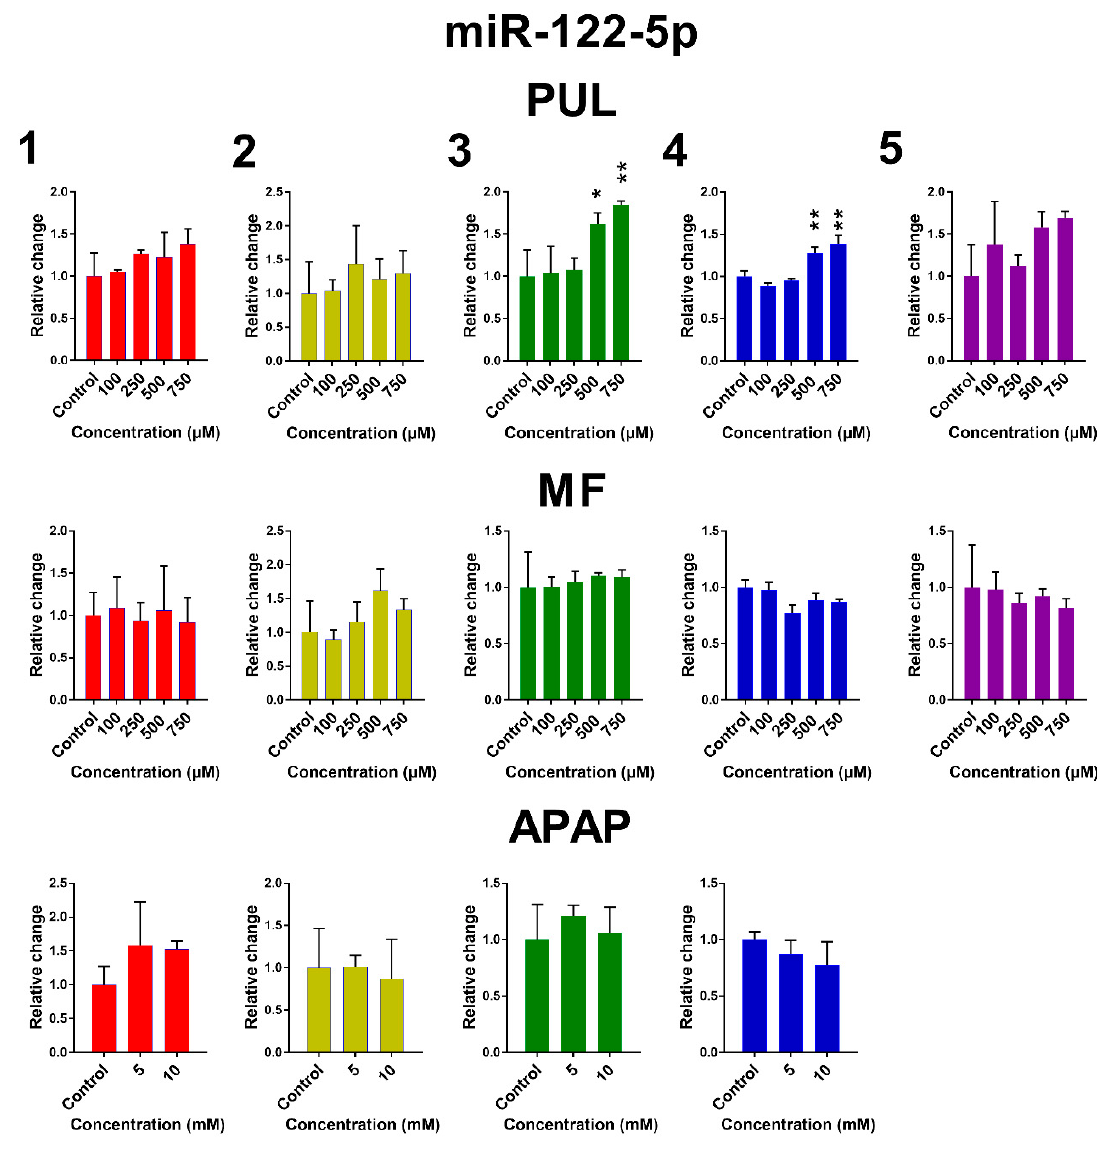
Figure 5. Figure 5. Cont.